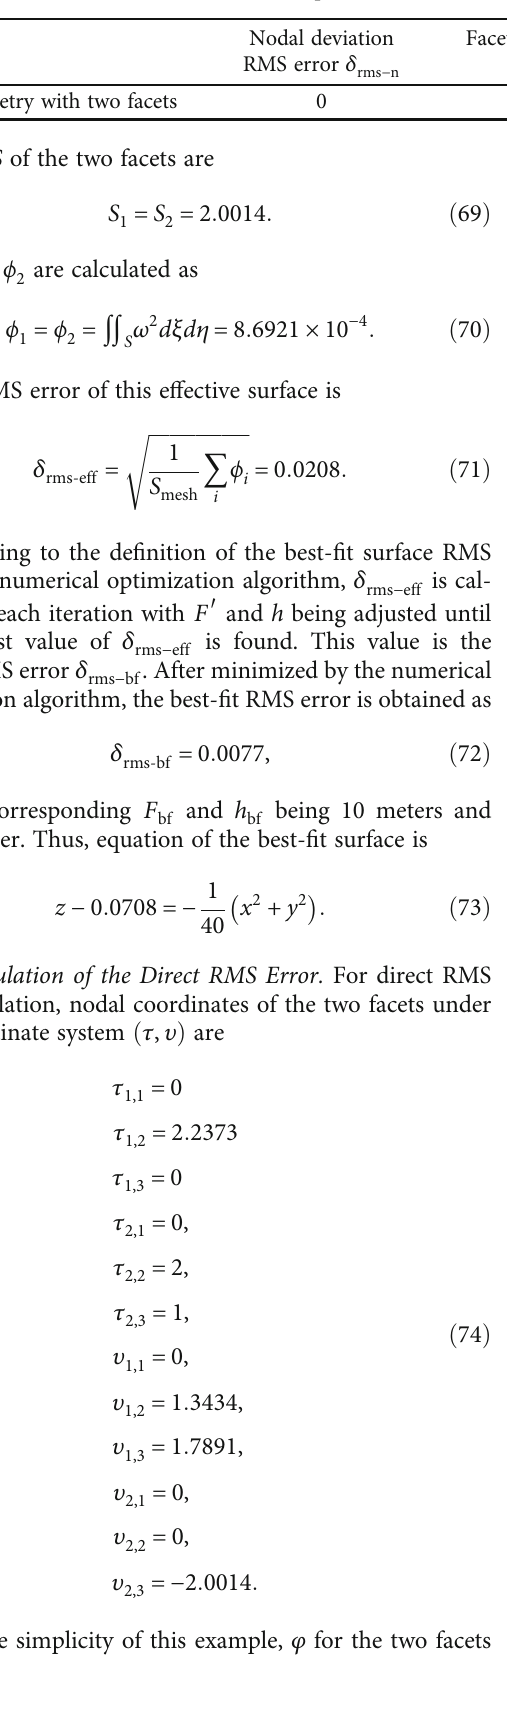
Table 2: Comparison of di ff erent RMS error calculation methods